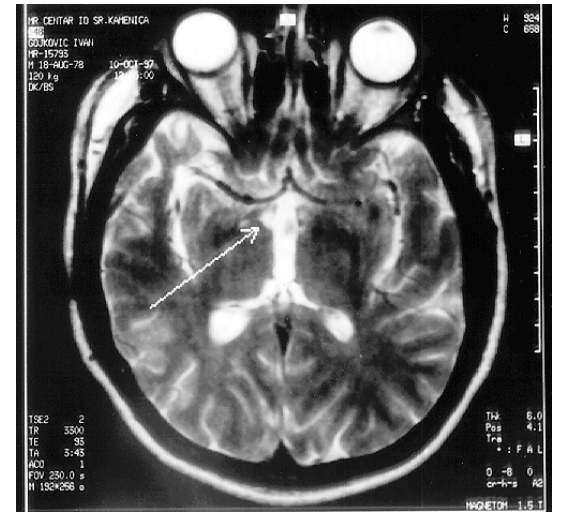
Fig. 2. A T2 weighted MR image shows high intensity lesion in the right hypothalamus (arrow) and in the right temporal